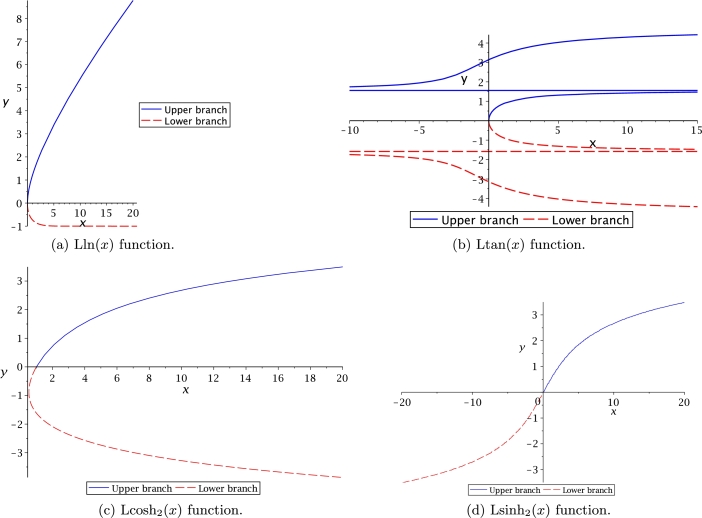
Leal-functions behaviour.